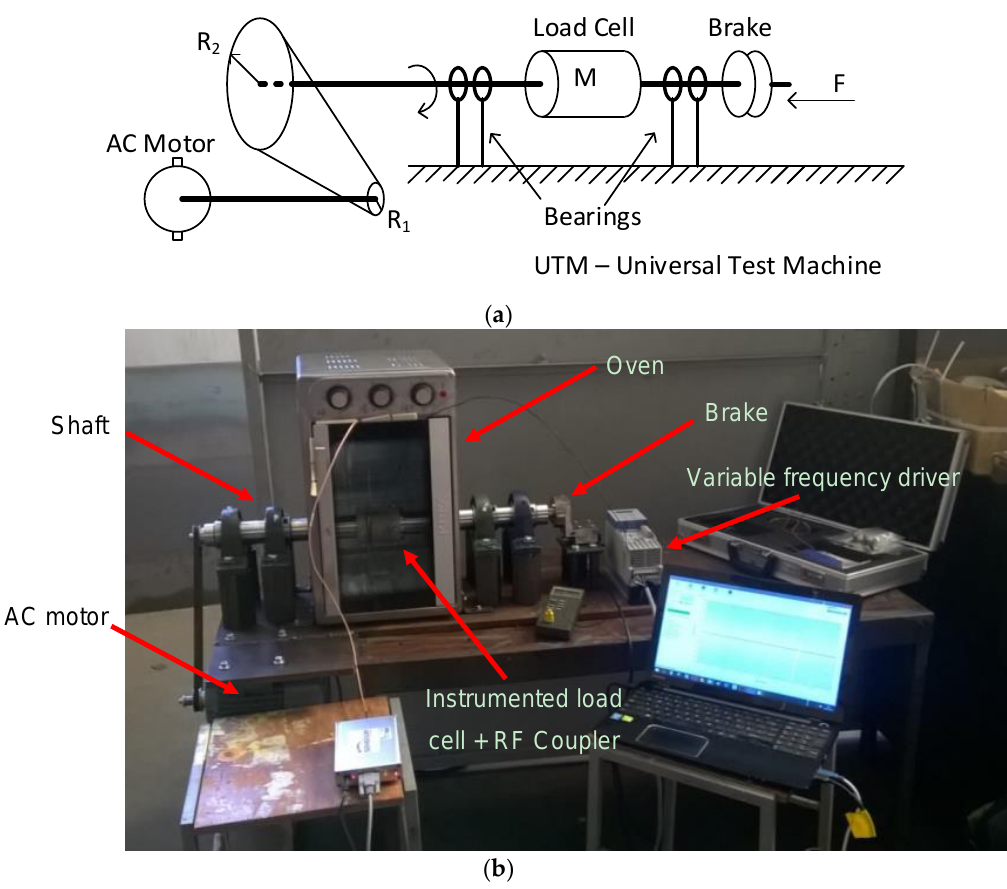
Figure 5. ( a ) simplified schematic representation of the setup used for measurements under rotation; ( b ) setup assembled for tests under rotation.